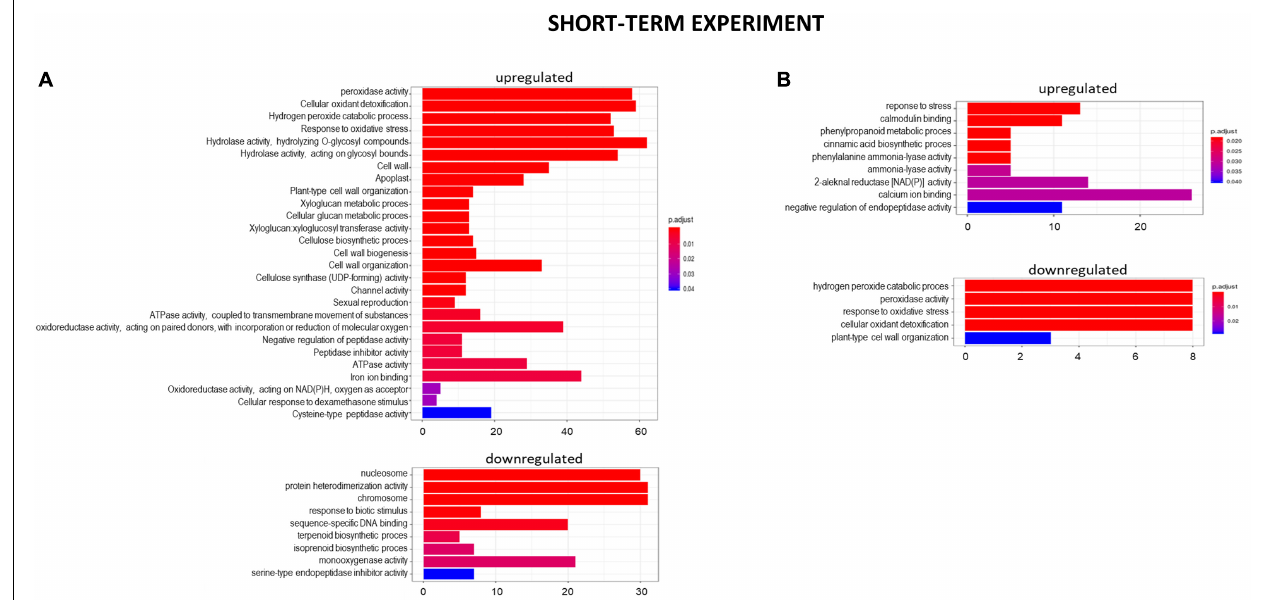
FIGURE 7 | GO term enrichment of genes upregulated and downregulated in the short-term experiment by low pH (A) and Al (B) . The numbers on the X axis indicates the number of genes; p.adjust means FDR adjusted p -value.